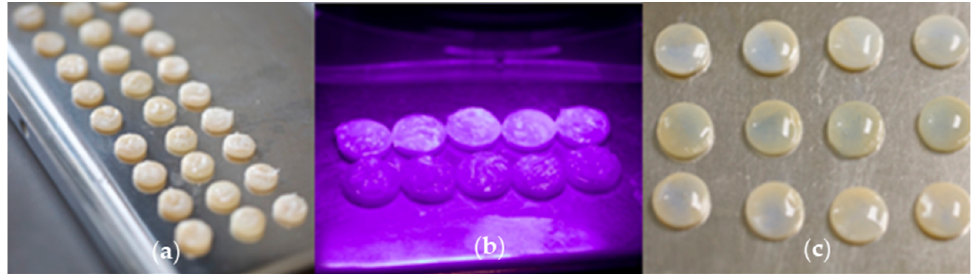
Figure 1. Bleaching of dental ceramics: ( a ) samples bleached with 16% carbamide peroxide, ( b )